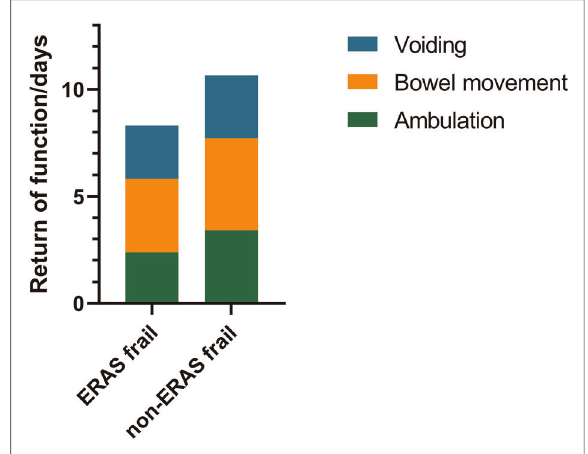
FIGURE 1 Stacked bar graph denoting recovery of physiological function for the ERAS frail group and the non-ERAS frail group. ERAS, enhanced recovery after